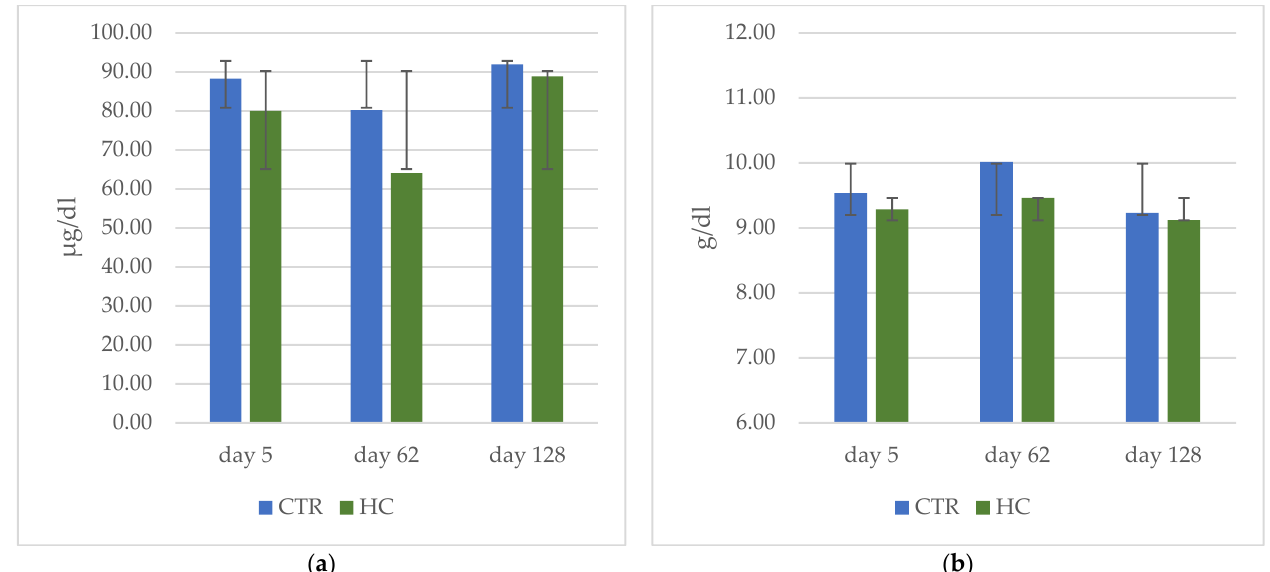
Figure 2. Health status parameters for CTR (control group) and HC (Hemp group) taken in three different periods: Initial, at the beginning of the trial; Intermediate, in the middle of the trial and Final, at the end of the trial. ( a ) Iron values ( b ) Hemoglobin values.